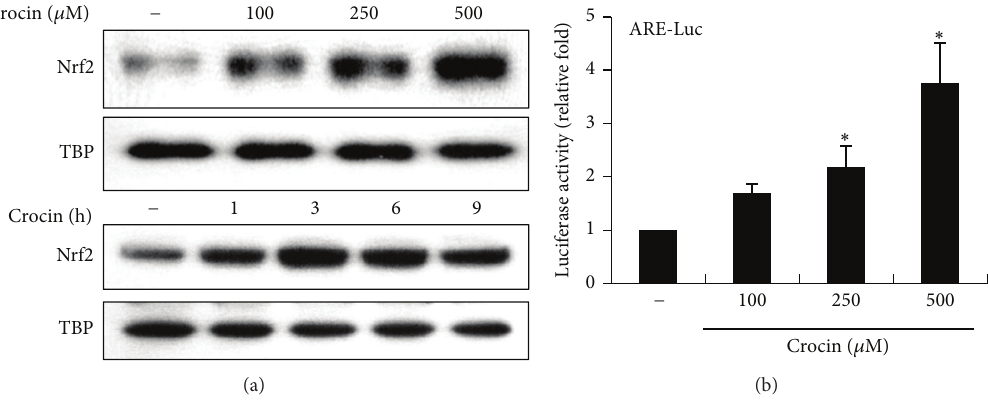
Figure 4: Activation of Nrf2 by crocin. (a) RAW 264.7 cells were incubated with the indicated concentrations of crocin for 3 h (upper panel) or with 500 𝜇 M crocin for various periods (lower panel), after which nuclear extracts were harvested and assayed by Western blotting. TATA binding protein (TBP) was used as a loading control. (b) Cells were transfected with ARE-luciferase construct and then treated with the indicated concentration of crocin. Equal amounts of cell extracts were then assayed for dual luciferase activity. ∗ 𝑃 < 0.05 versus the group treated with PBS